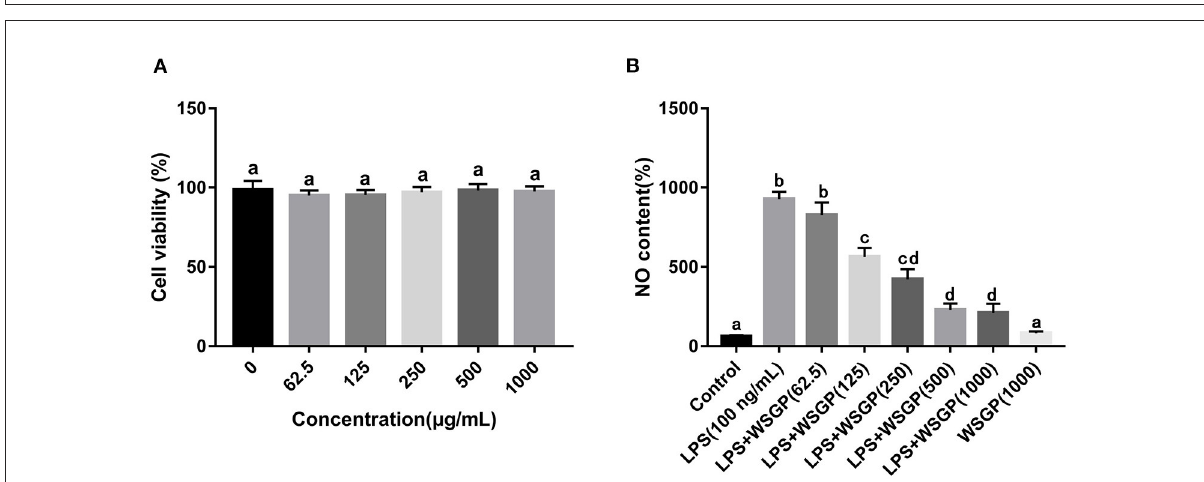
FIGURE4 Effects of WSGP on cytotoxic (A) and LPS-induced NO production (B) in RAW264.7 macrophage cells. The data were expressed as means ± SD from three independent experiments. Values with different letters indicate significant difference ( p < 0.05).